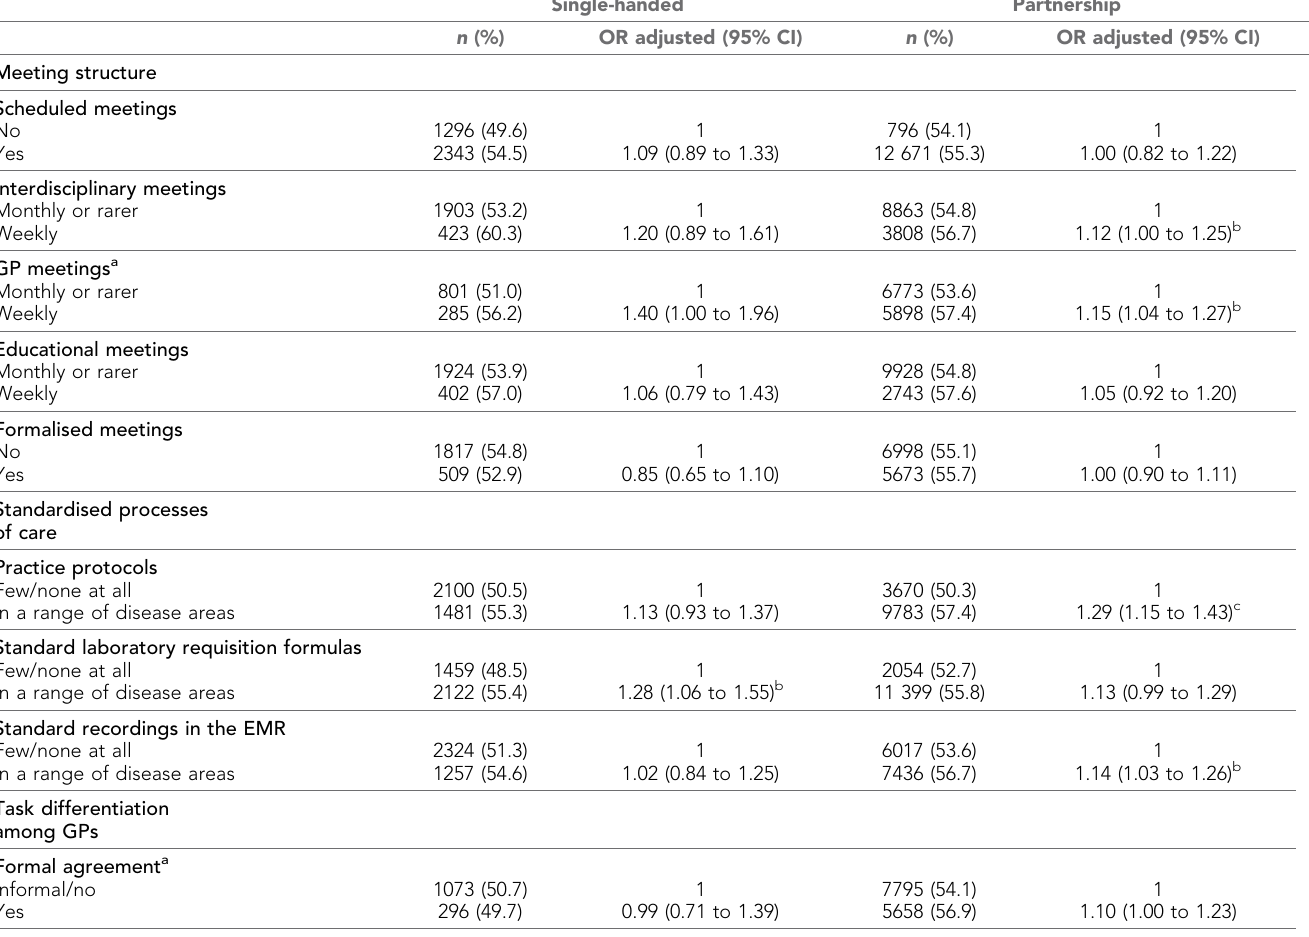
Table 2. Associations between implementation activities and patients having spirometry